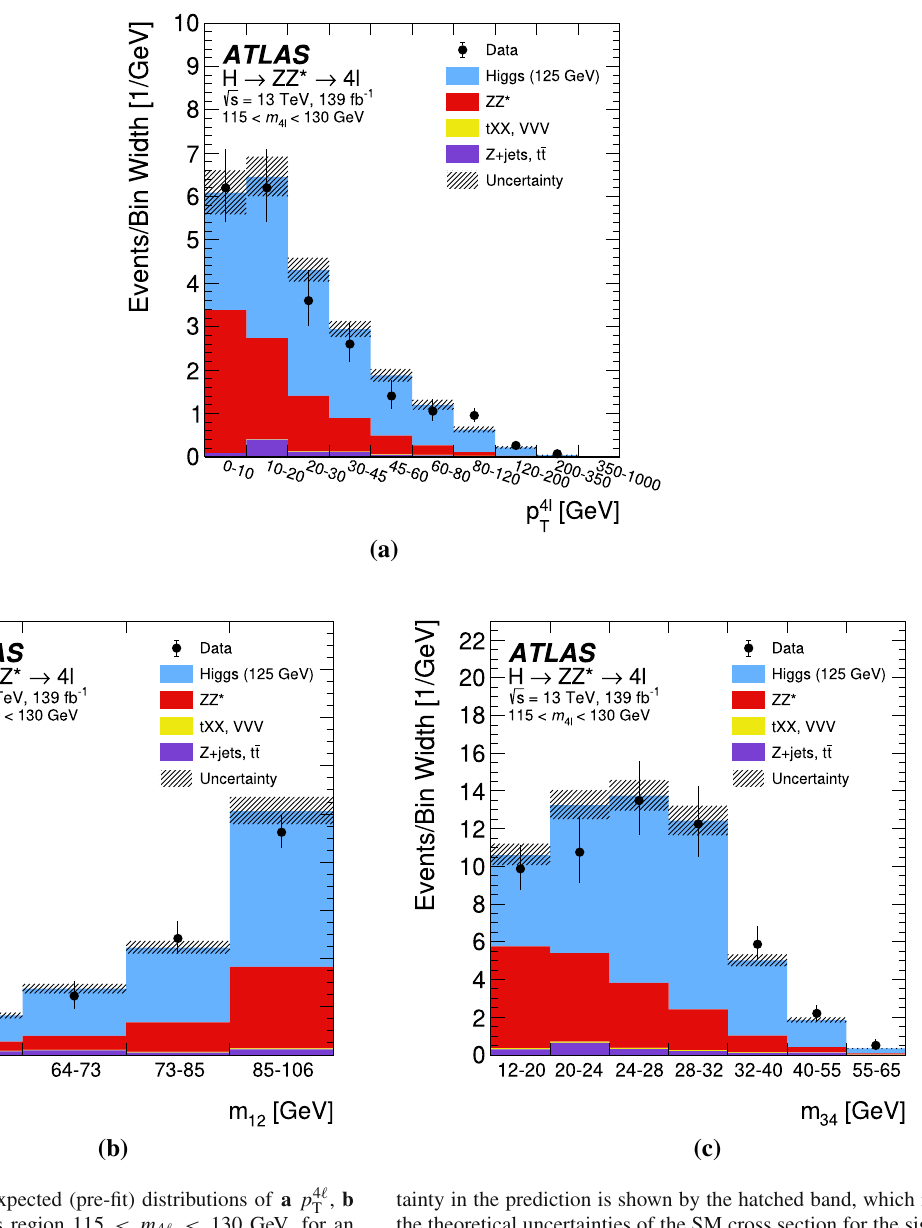
, b tainty in the prediction is shown by the hatched band, which includes T the theoretical uncertainties of the SM cross section for the signal and √ s = 13 TeV. A SM the Z Z ∗